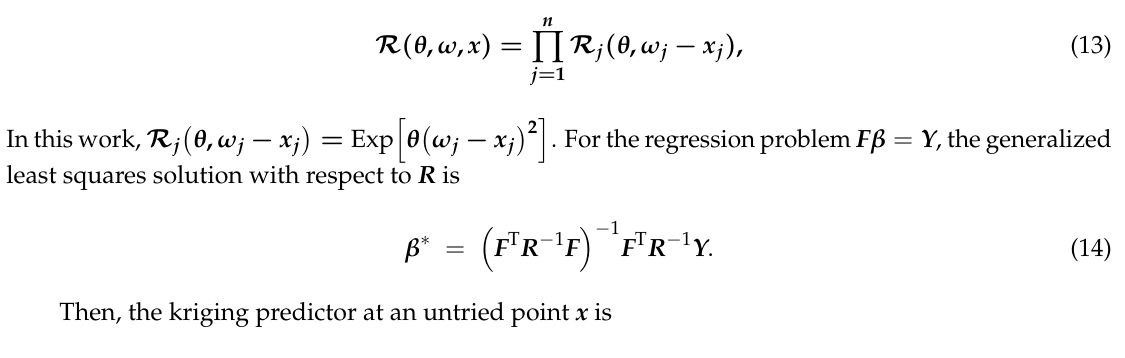
Table 11. Method validation and error.